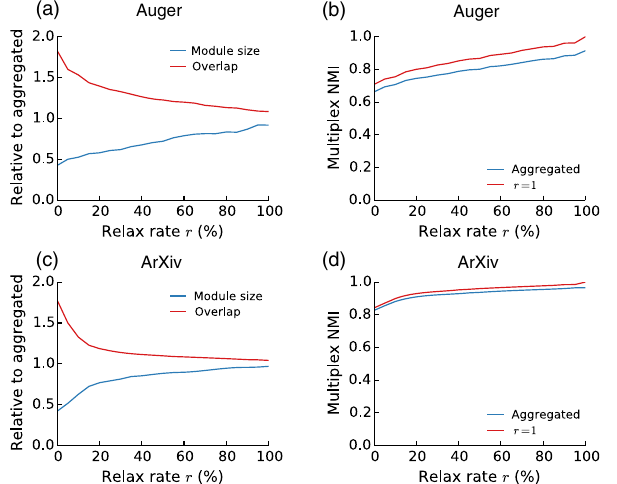
FIG. 7. Modules span more layers and overlap less with increased relax rate. Panels (a) and (c) show the number of nodes as a function of the memberships they have, i.e., the number of modules the nodes belong to, for several values of the relax rate. For each node, the maximum number of memberships is the number of layers where the node appears: This is very close to what we get for r ¼ 0 , although the curves are not exactly the same. For r ¼ 1 , we still have some overlap compared to the aggregated one, which is just a single point because each node belongs to one single module. Panels (b) and (d) show the number of modules that are present in the number of layers indicated on the x axis. For small values of r , the modules tend to be localized in fewer